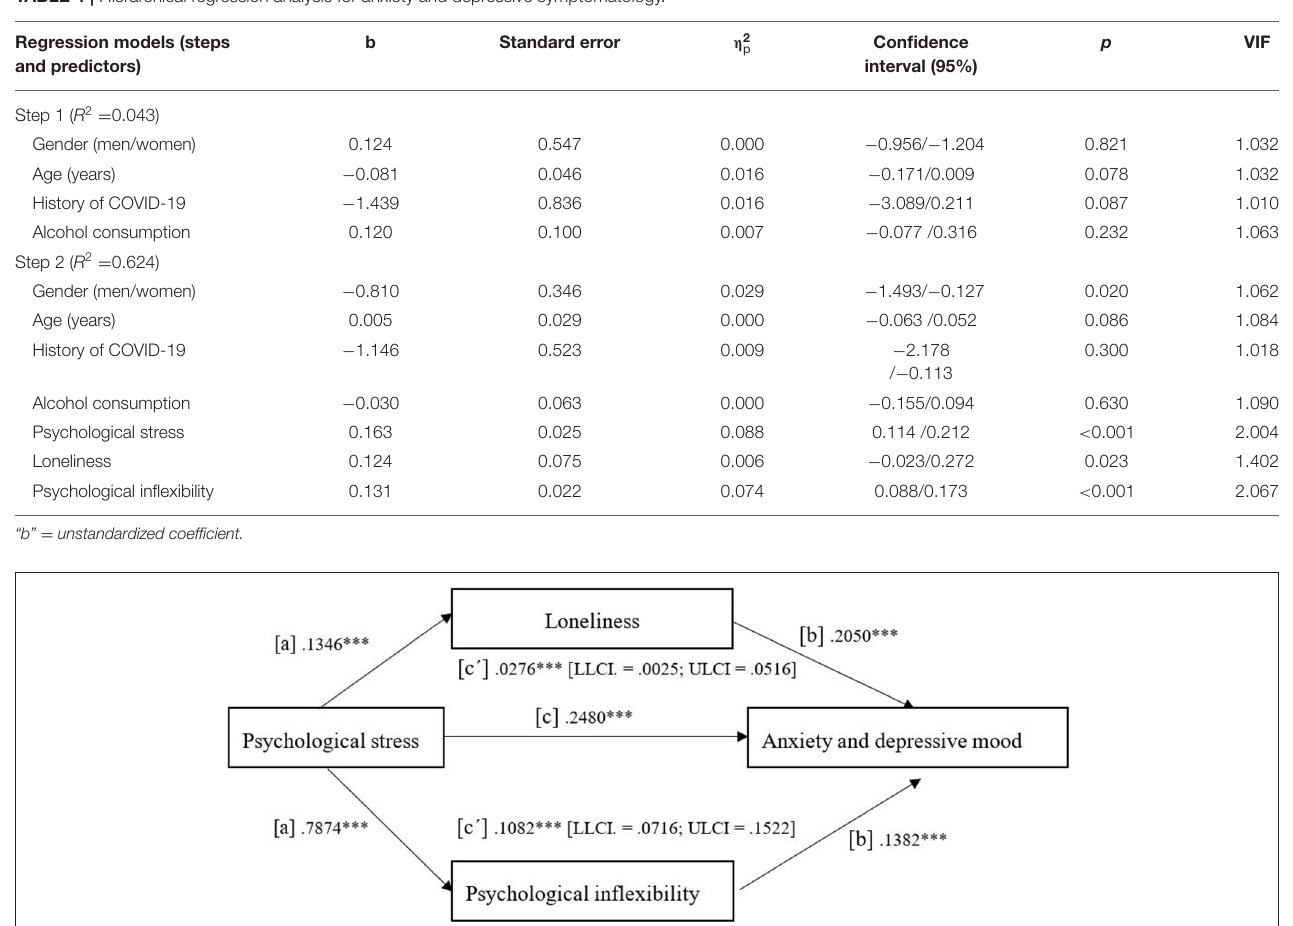
TABLE 4 | Hierarchical regression analysis for anxiety and depressive symptomatology.